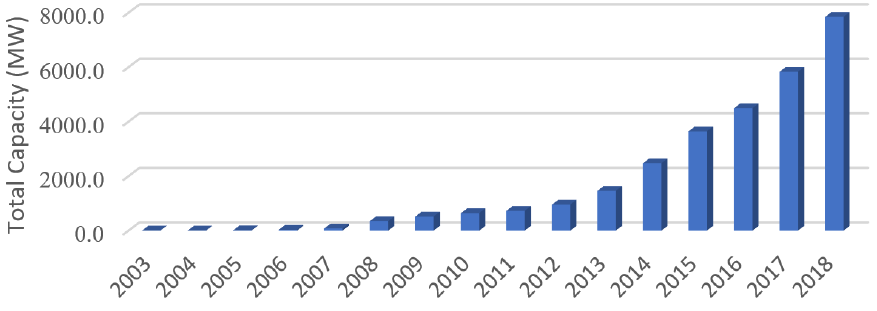
Figure 2. Cumulative solar power capacity in South Korea [32].